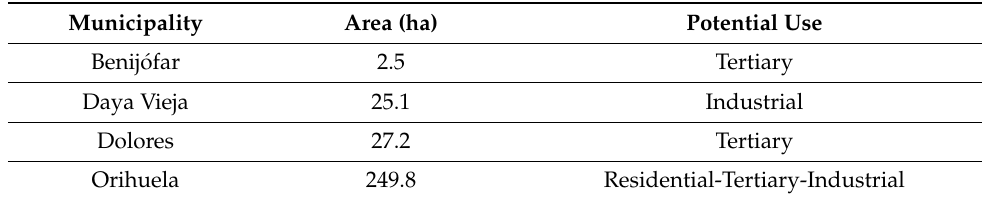
Table 4. Municipalities with non-delimited developable land at risk of flooding. Own elaboration based on